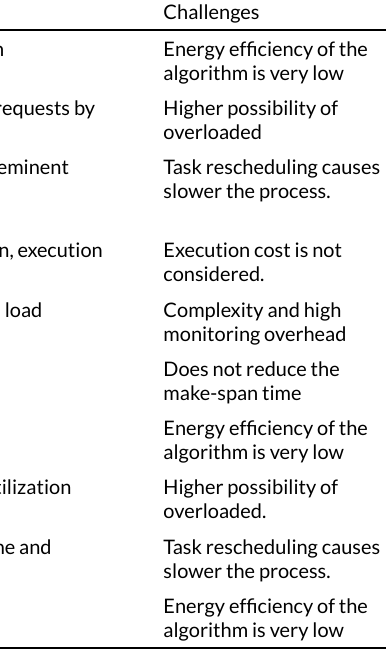
Table 1. Summary of Research Gap.